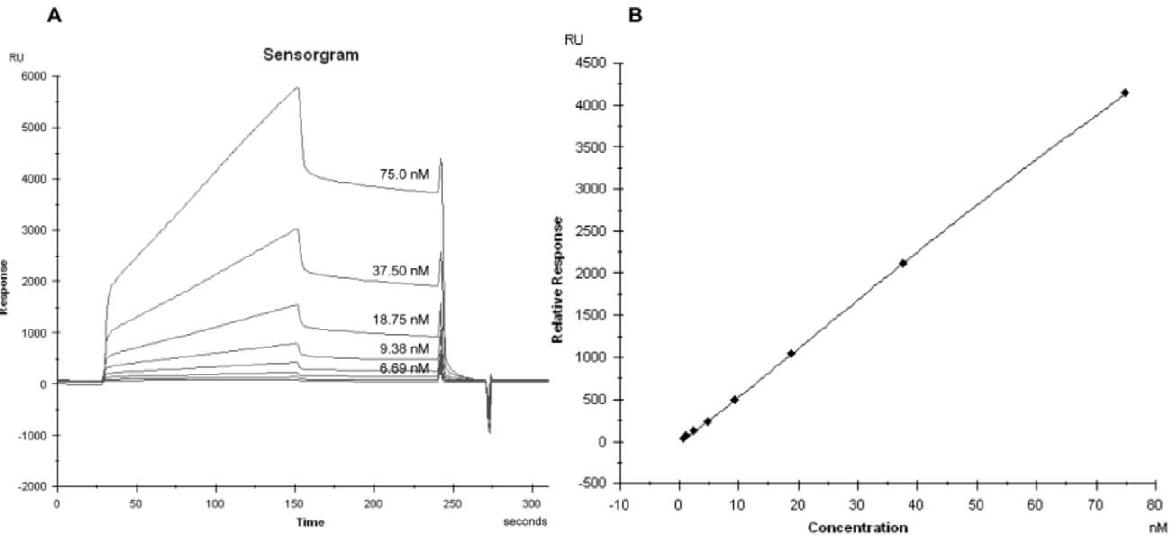
Figure 2. Calibration curve. (A) Sensorgram and (B) Standard curve of resonance units (RU) vs. antibody concentration as determined with an anti- human-PI polyclonal serum. The concentration values of polyclonal antibody used in the standard curve were: 75 nM, 37.50 nM, 18.75 nM, 9.38 nM, 6.69 nM, 2.34 nM, 1.17 nM and 0.59 nM.